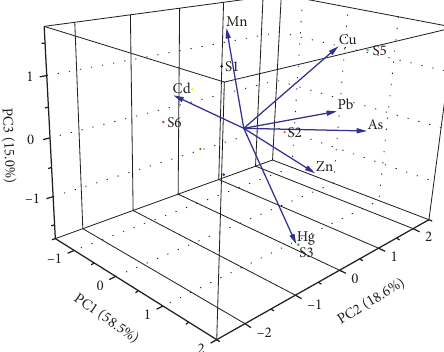
Figure 4: The three-dimensional output result of